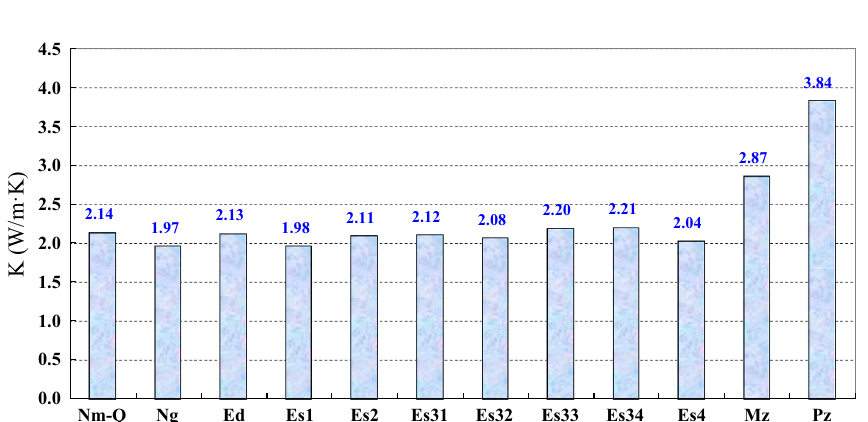
Figure 5. Rock thermal conductivities of different strata. The rock thermal conductivities of the Quaternary, Minghuazhen and Guantao Formations refer to the rock thermal conductivities of the Jiyang Subbasin 24